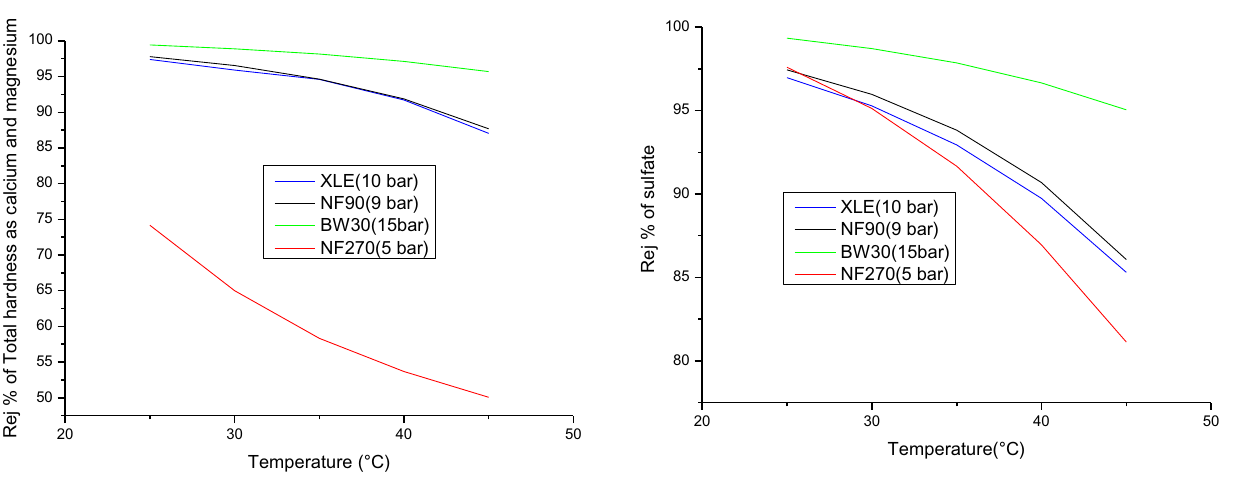
Fig. 10 Effect of temperature on TH % removal at optimum feed pressure for conf a